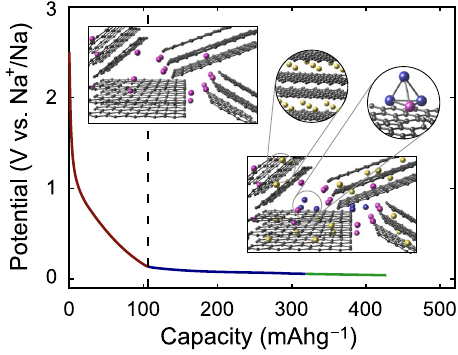
Fig. 4 Identi fi ed sodiation mechanism of HC. Schematic diagram of charge – discharge curve with the related